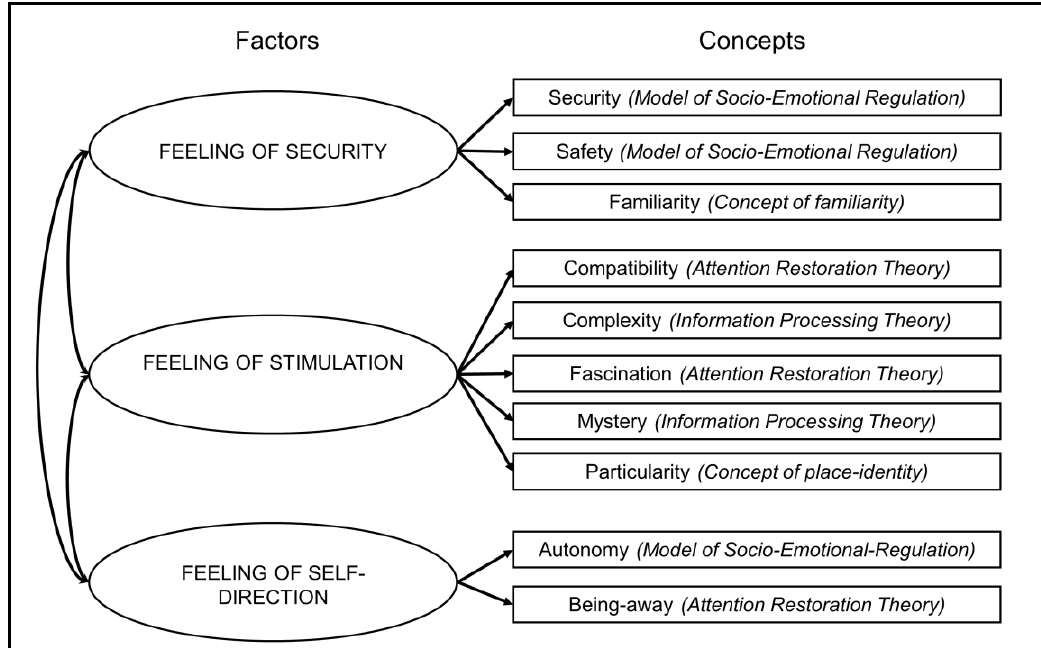
Figure 1. The three factors of interrelated theoretical concepts: feeling of security, stimulation and self-direction (based on Gehring,